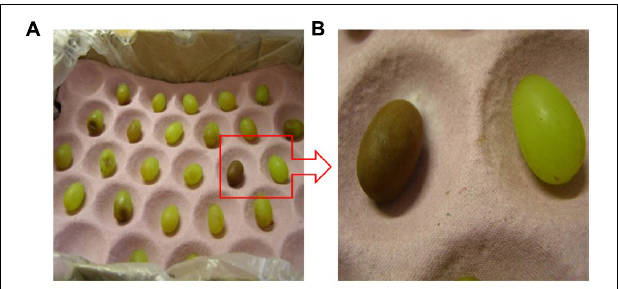
FIGURE 7 | A ‘Thompson Seedless’ berry is showing (A) no signs of browning on the inside and (B) onset of internal browning around the vascular tissue. TABLE 3 | The number of runs done for each cold storage condition (week 3 and week 4; week 5 and week 6) and browning defect, chocolate browning (CB), and friction browning (FB) of the ‘Regal Seedless’ table grape bunches.